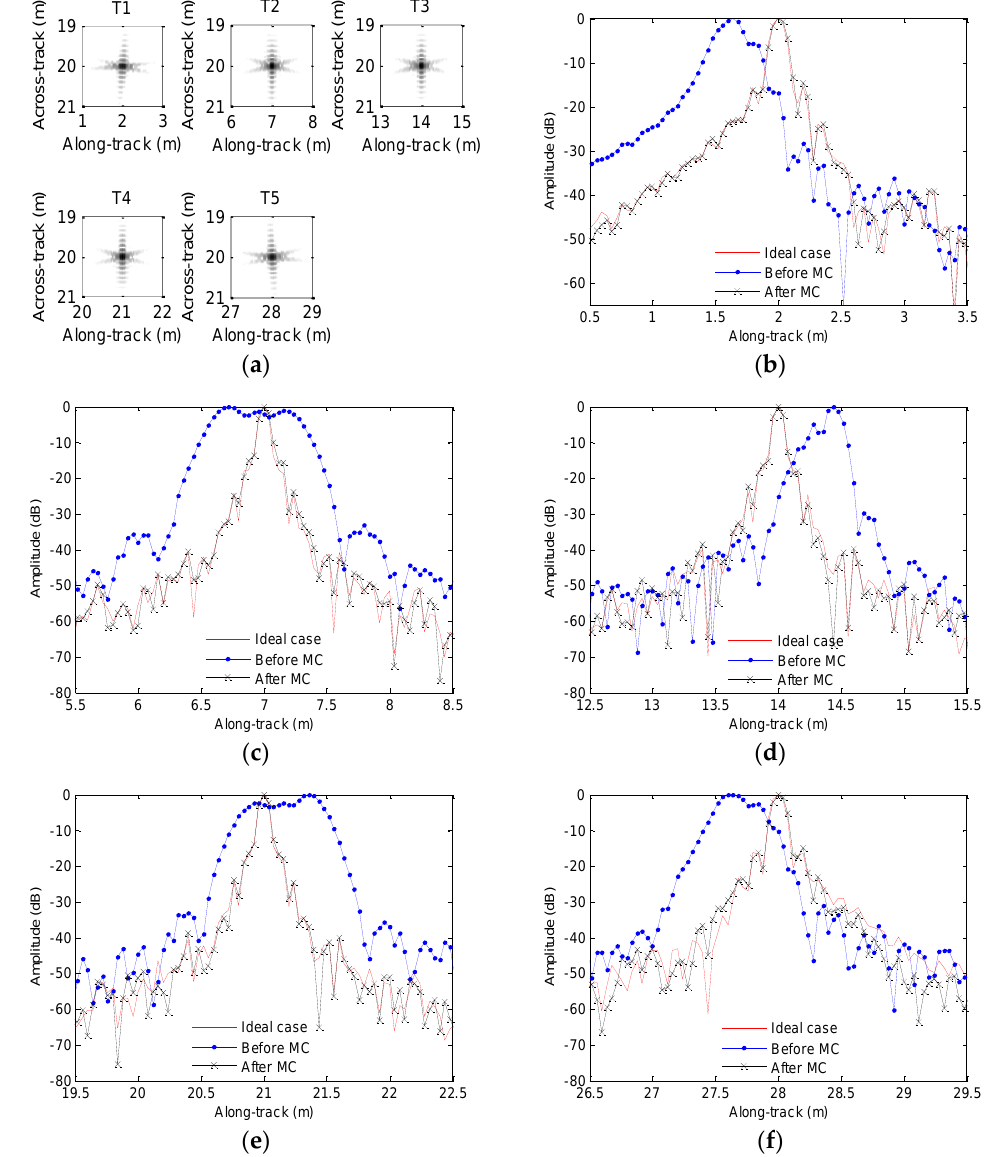
Figure 21. Results for the sinusoidal heave: ( a ) imaging result; ( b ) slice T1; ( c ) slice of T2; ( d ) slice of T3; ( e ) slice of T4; ( f ) slice of T5.